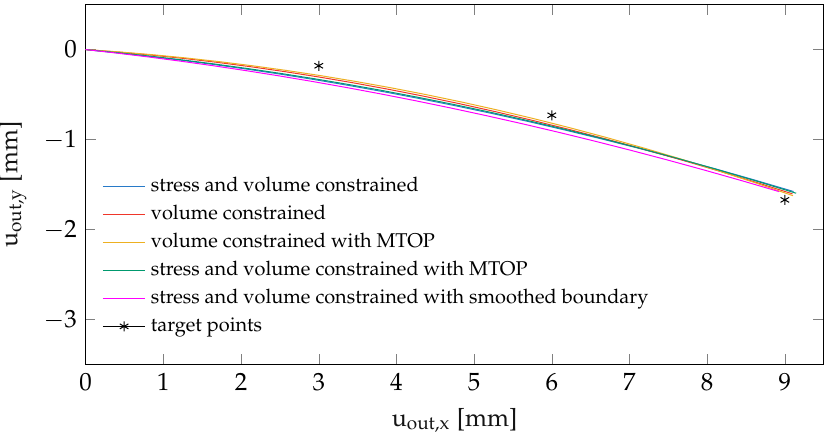
Figure 9. Output paths for path generation mechanism example solutions in Figures 6 and